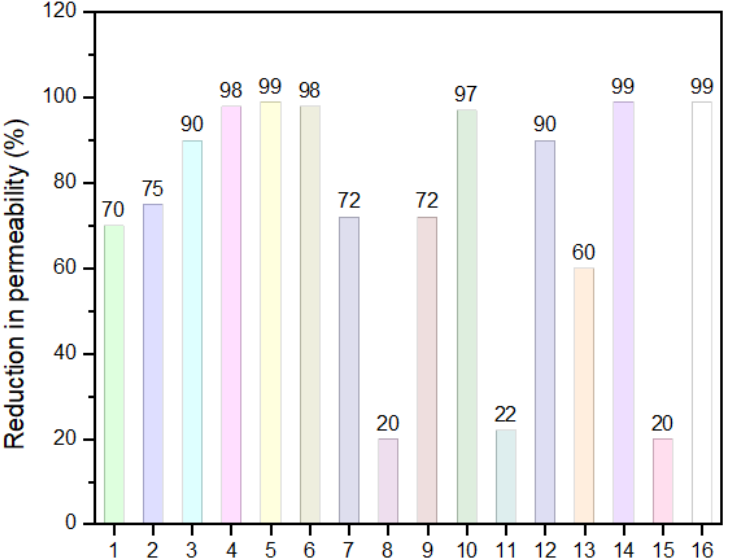
Figure 4. Maximum permeability reductions in percentage achieved by different researchers in